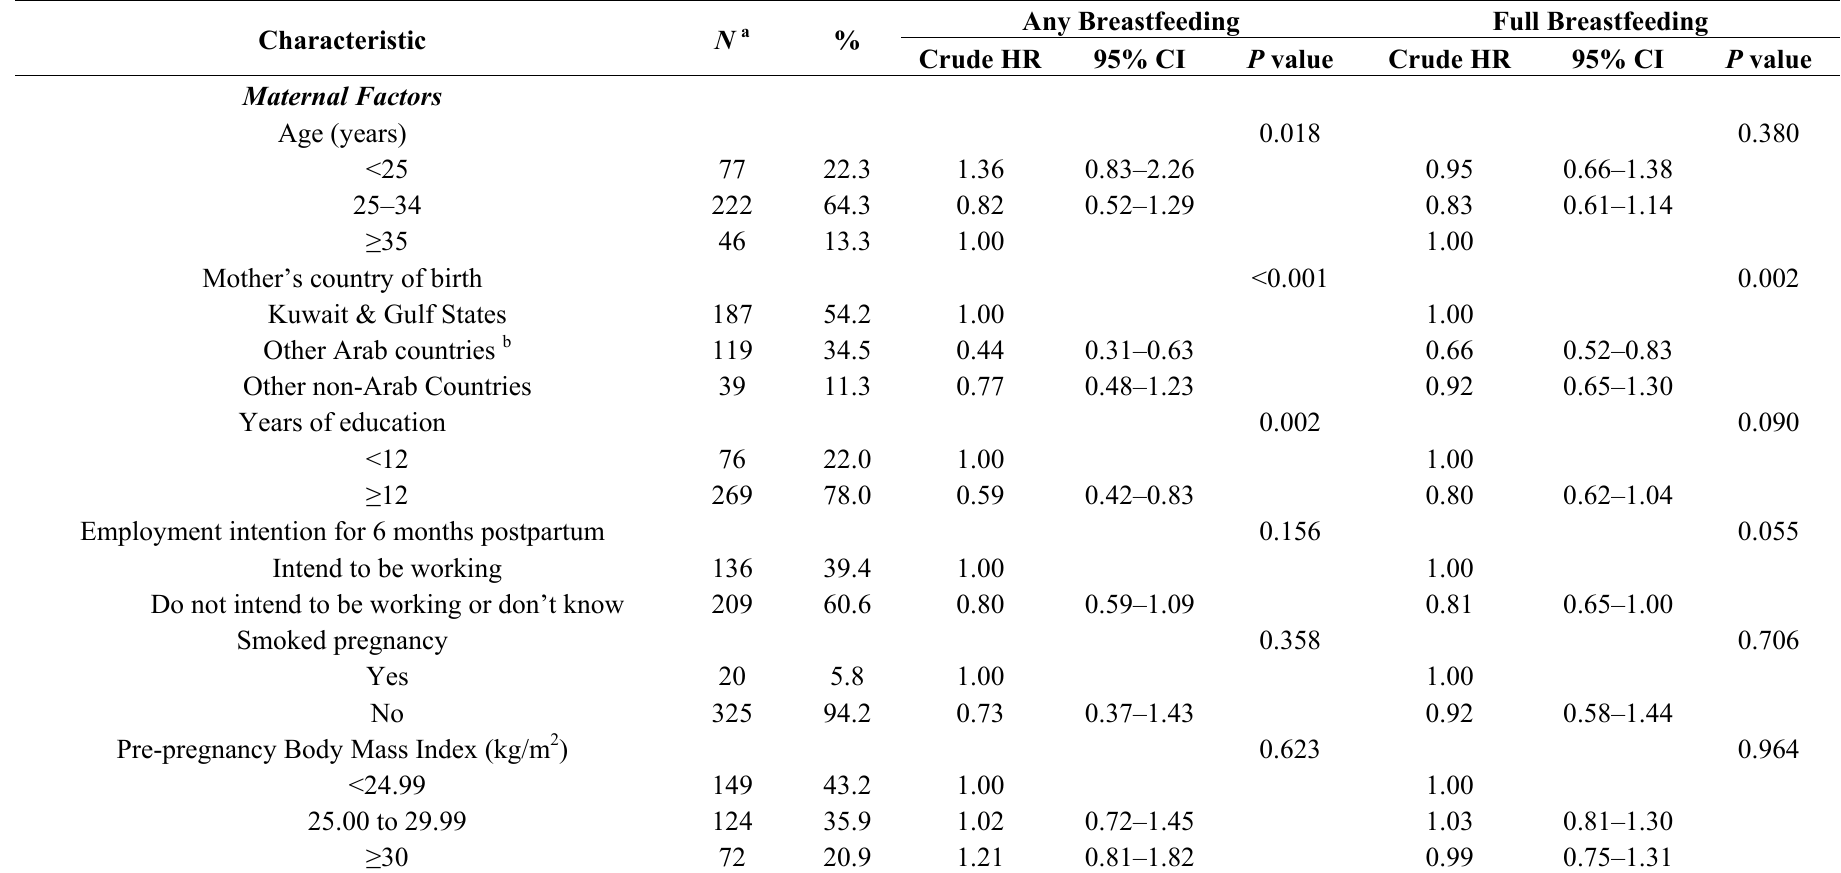
Table 2. Characteristics of a cohort of mother-infant dyads who had breastfed ( n = 345) and the unadjusted association with the risk of discontinuing any or full breastfeeding during the six months’ follow-up (Crude Hazards Ratio and 95% Confidence